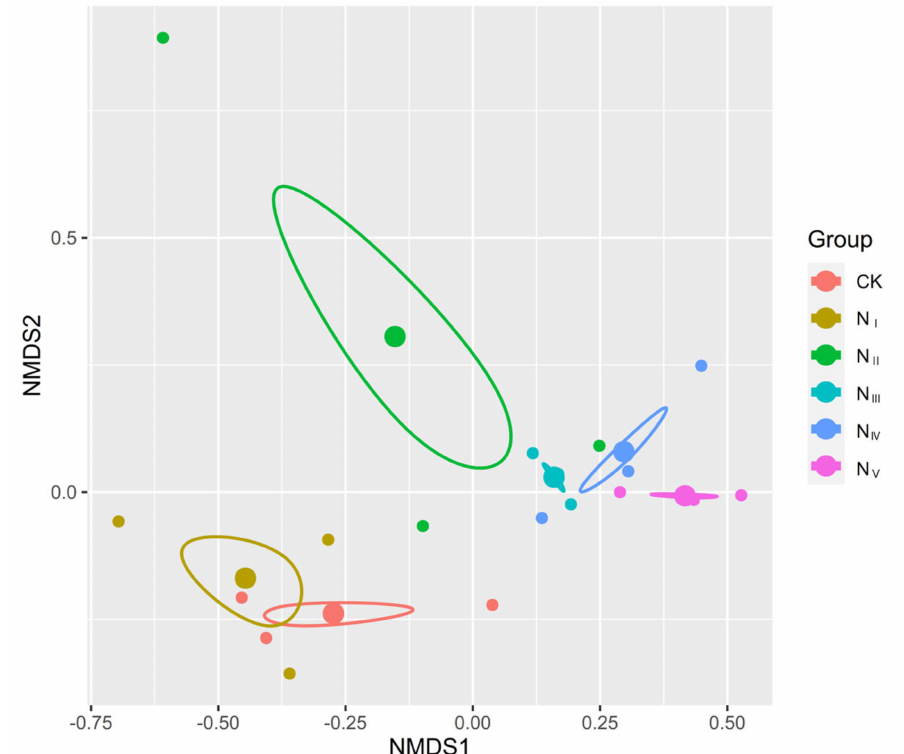
Figure 1. Non-metric multidimensional scaling plot of species abundance between different N addition rates. Dots of the same color come from the same group. Each small dot represents a plot replication, and each large dot represents the mean value of three plot replications. Circles indicate the 95% confidence of the mean value. The closer the distance between the two points or circles, the smaller the difference between the two groups. Abbreviations: CK, N I , N II , N III , N IV , and N V are 0, 8, 24, 40, 56, and 72 kg N ha − 1 · y − 1 , respectively; similarly for the following figures and